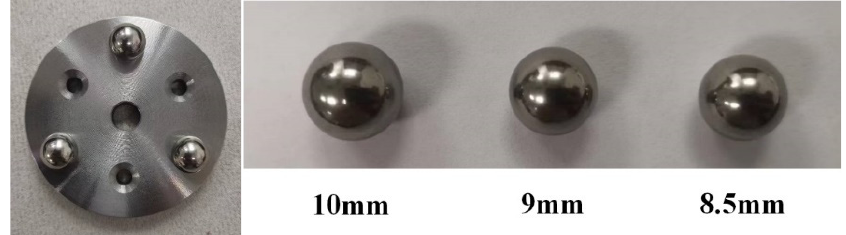
Figure 22. Steel ball and installation position.